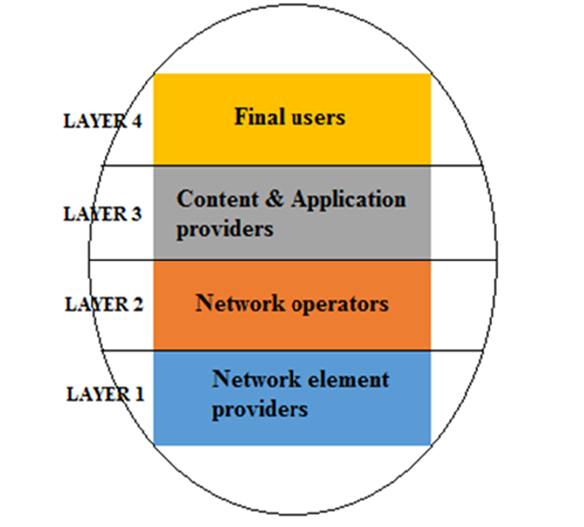
Fig. 1. The four-layer